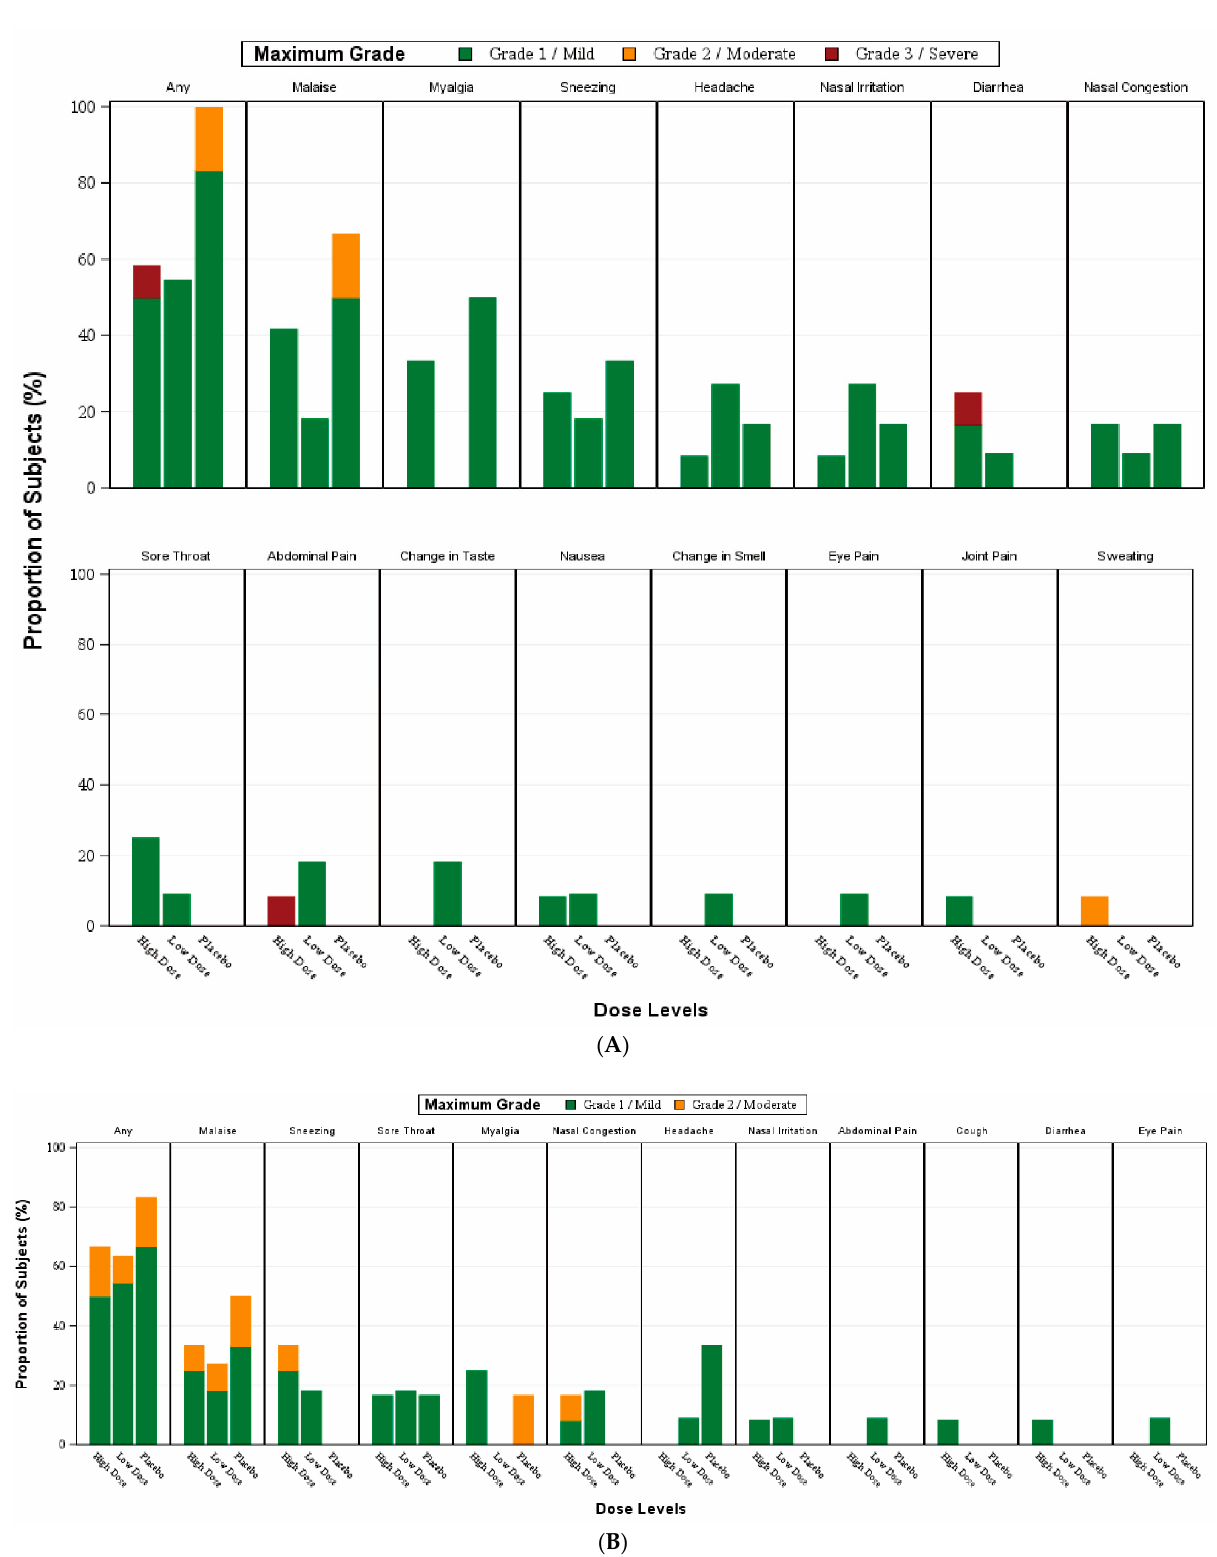
Figure 3. Reactogenicity events reported for the 14-day period after each vaccination with DelNS1- nCoV-RBD LAIV. Subjects received two doses of test vaccine or placebo on day 1 and day 29, and were then required to record any AE in the diary for a 14-day period after each vaccination. ( A ) AE occurred in subjects after the first vaccination. ( B ) AE occurred in subjects after the second dose. Fisher’s exact test was used to analyze the AEs in the three